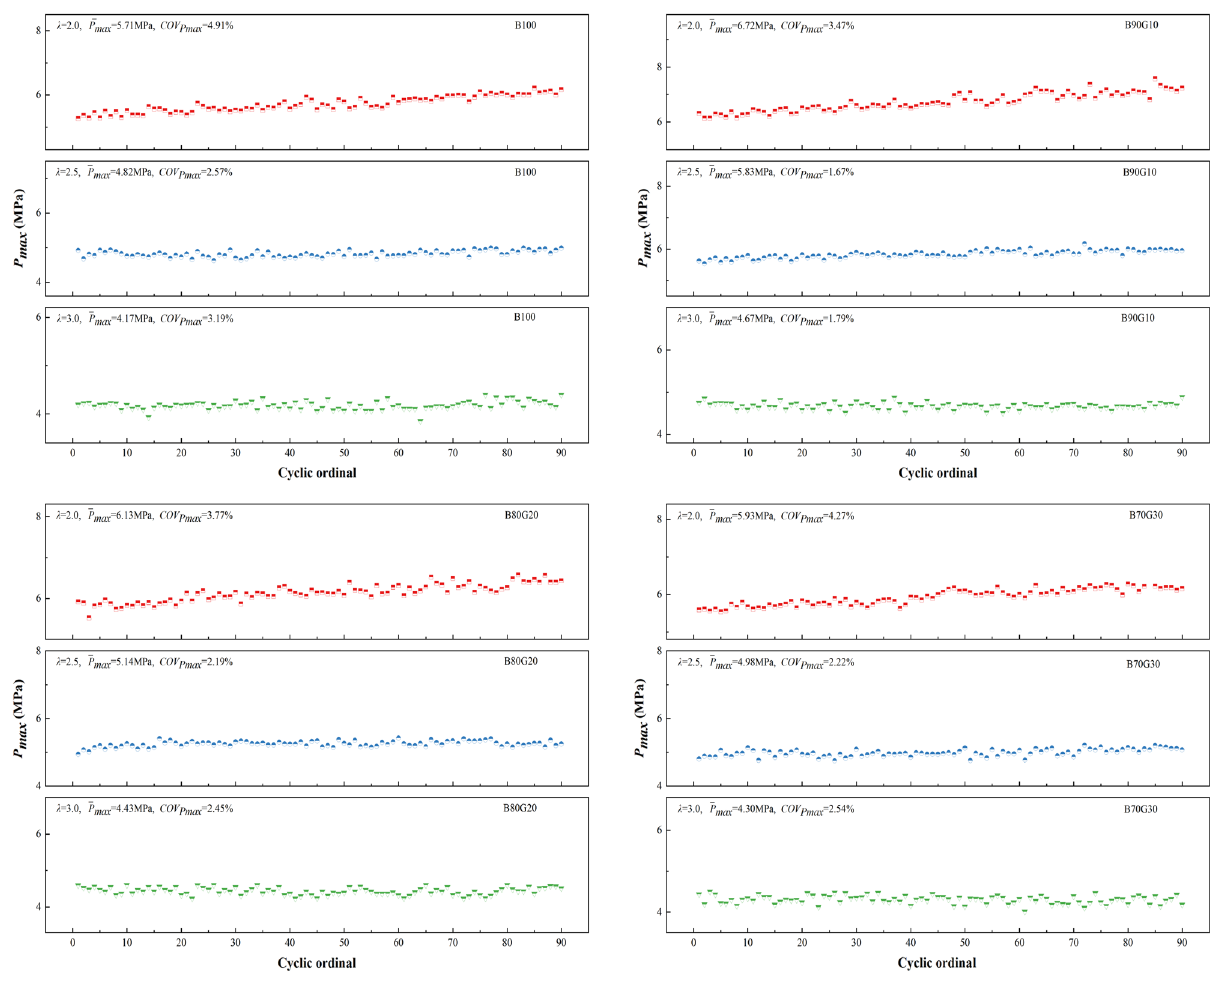
Figure 7. Cyclic variation with different λ